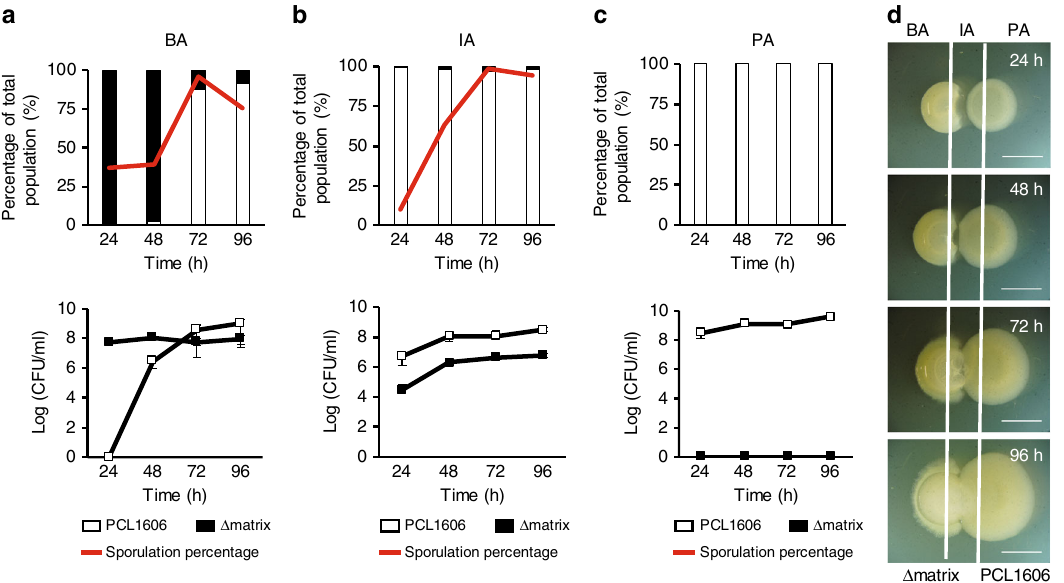
Fig. 2 B. subtilis Δ matrix coexists with PCL1606 in the form of spores. a – c show (upper part) percentages and (bottom part) Log (CFU/ml) of PCL1606 (empty bars and squares) and Δ matrix (black bars and squares) in three different sections (BA [ Δ matrix area], IA [Intermediate area], and PA [PCL1606 area]) of the interaction at different time-points (24 h, 48 h, 72 h, 96 h). Sporulation rates are shown as red lines. d Scheme of the interactions and the sections: BA ( Δ matrix area), IA (Intermediate area) and PA (PCL1606 area). Scale bar = 5 mm. Cells from the three sections of the interaction were collected, sonicated and completely resuspended, diluted and plated to determine colony-forming units (CFU), sporulation rates and percentages of each species over the total bacterial population in the interaction. Average values of three biological replicates are shown, with error bars representing SD. Source data are provided as a Source Data fi (CFP)-expressing B. subtilis strains were spotted at a distance of